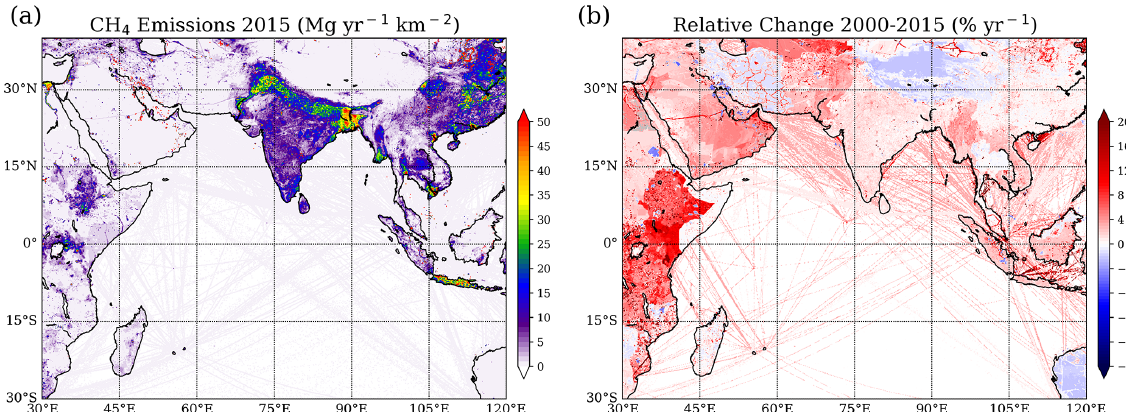
Figure 5. Annual mean CH 4 emissions for 2015 (a) and relative change with respect to 2000 (b) from EDGAR V5.0_GHG.